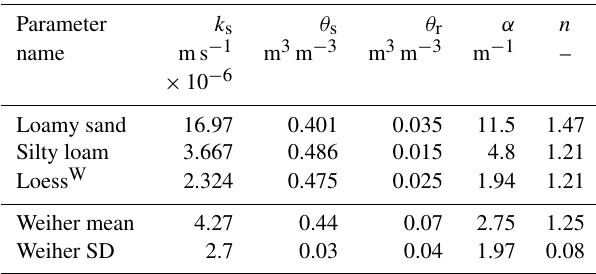
Table 2. Soil matrix retention parameters used in the application tests. Loamy sand and silty loam according to Carsel and Parrish (1988). Loess W refers to measured values from soils at the location of the experiment described in Sect. 4.2. Weiher comprises seven ensemble soil matrix references of the Weiherbach basin as mean and standard deviation